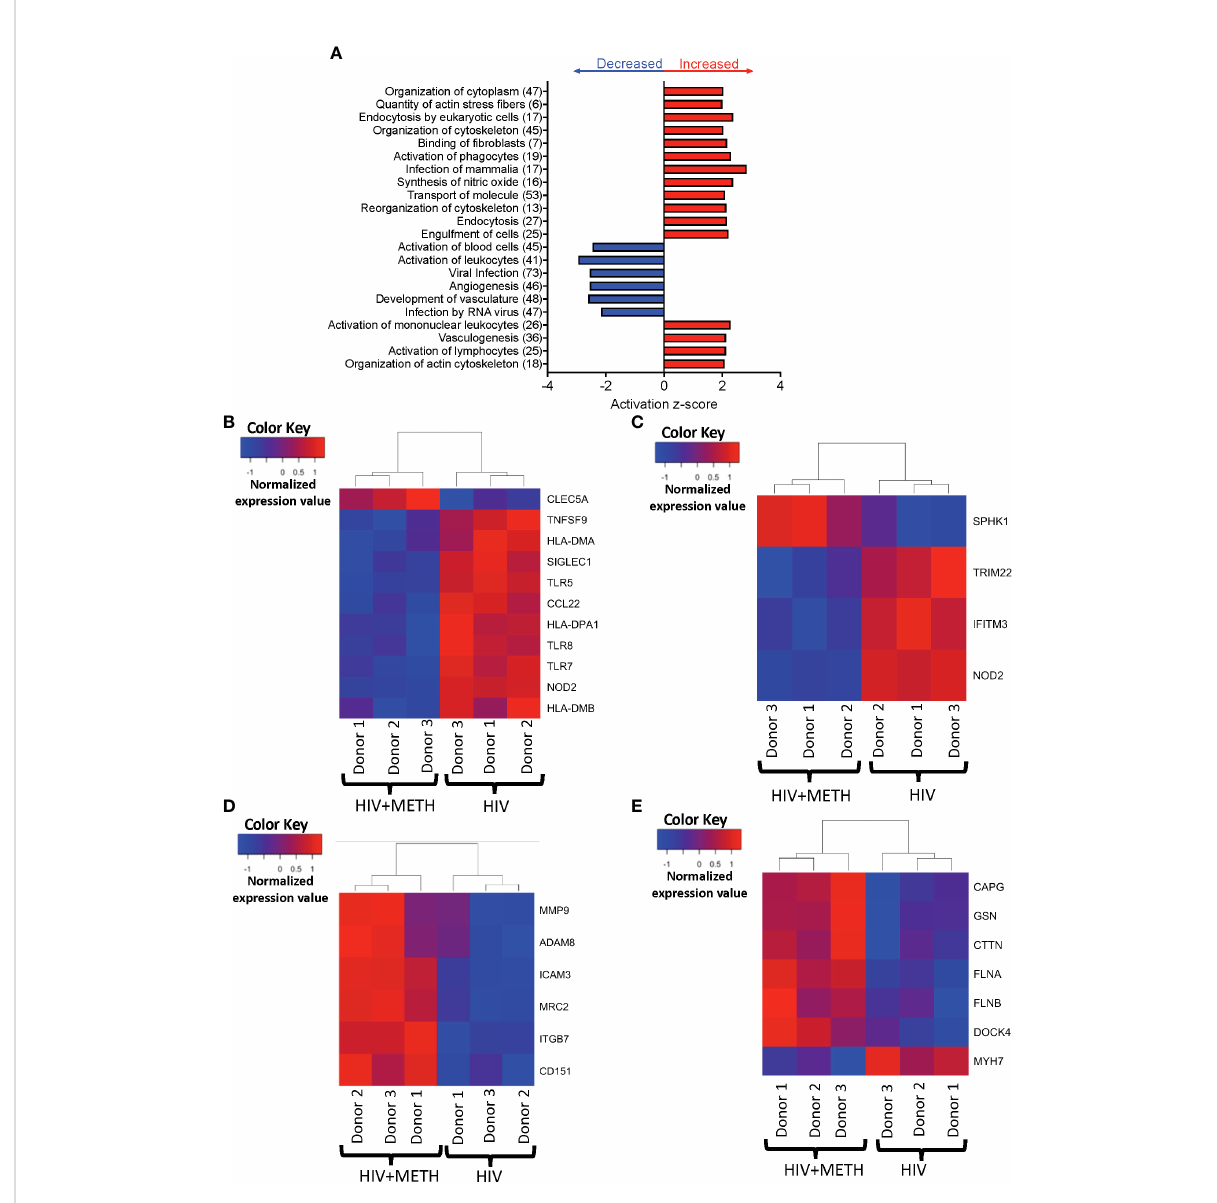
FIGURE 2 HIV-infected mature monocytes treated with meth compared to untreated HIV-infected cells have a predicted increase in viral infection and cytoskeletal rearrangement and decrease in cell activation. (A) Top functions predicted to be increased (red) or decreased (blue) in the meth treated compared to untreated HIV-infected cells. The y-axis represents the list of functions, and the numbers in the parenthesis represent the quantity of molecules that were differentially expressed after meth treatment. The x-axis represents activation z-score. (B – E) Heat maps representing normalized expression levels of some genes involved in (B) activation of leukocytes, (C) viral infection, (D) cell adhesion and matrix degradation, and (E) organization of cytoskeleton in HIV-infected mature monocytes treated with and without meth. Each column represents an individual sample, and each row represents a gene. The color scale represents lower (blue) to higher (red) gene expression levels. The dendrograms show unsupervised clustering of